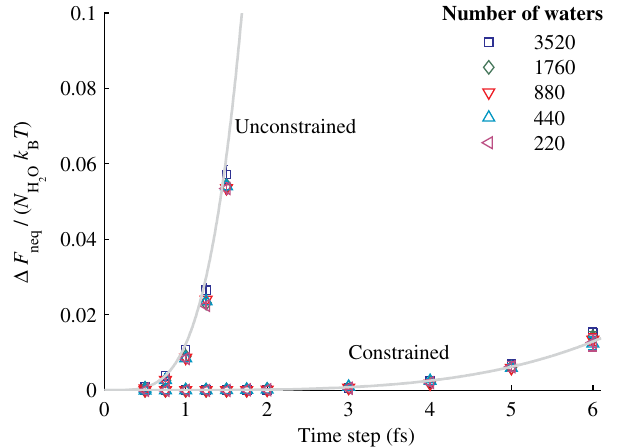
FIG. 2. Nonequilibrium free-energy deviation for boxes of TIP3P water, normalized by number of waters. Nonequilibrium free energies for various system sizes (220 to 3520 TIP3P waters) are shown for both unconstrained (left curve) and constrained (right curve) simulations, normalized of waters in the system and the thermal by the number N H 2 O energy k B T . Error bars show 95% confidence